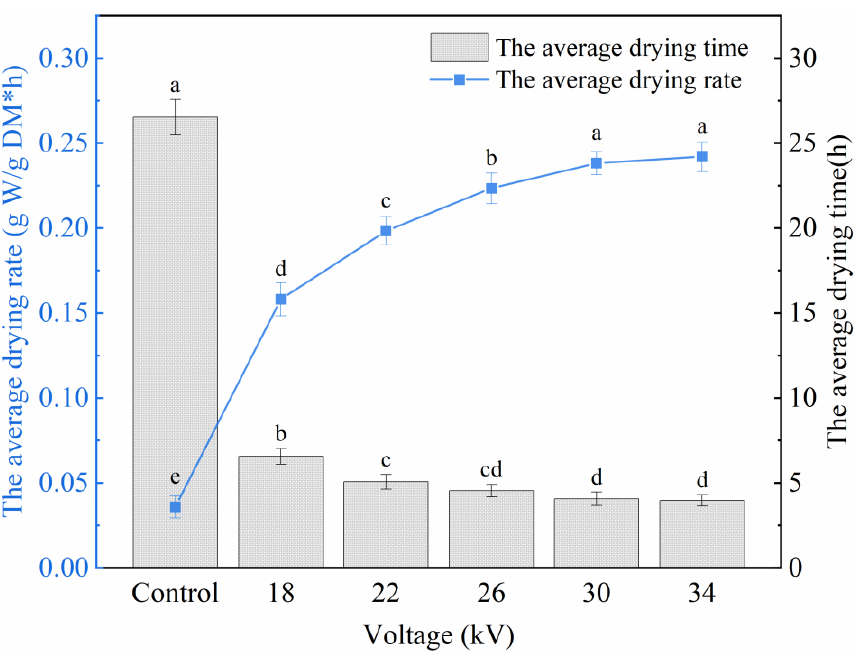
Figure 3. Average drying rate and average drying time of shiitake mushroom slices. Different letters indicate significant differences ( p < 0.05) between sample means.